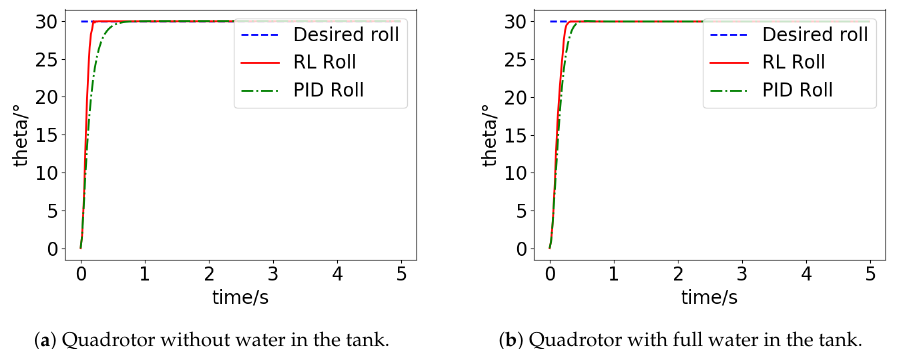
Figure 10. Step response performance of PID controller 1 along the roll axis.